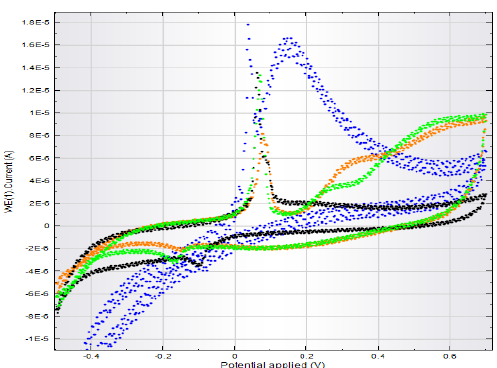
Figure A8. Overlapped CVs for the oxidation signal obtained for 0.5 mM H 2 O 2 in the absence (blue) and in the presence of 0.5 mM of the novel synthesized compounds: 8a (green) and 8b (orange) prepared in 0.1 M KCl on Au SPE. Black line: CV recorded in 0.1 M KCl.